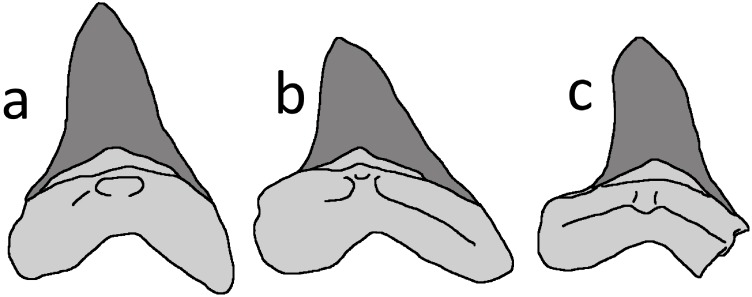
Cretoxyrhina mantelli anterior teeth.Tracing of Cretoxyrhina mantelli anterior teeth from Bourdon & Everhart (2011), their figure 5, mirrored from their original). (A) position 3 in the jaw; (B) position 4; (C) LACM 50926 tooth. The bases of the teeth are shaded in pale grey and the enamel is dark grey. Image credit: David Hone.